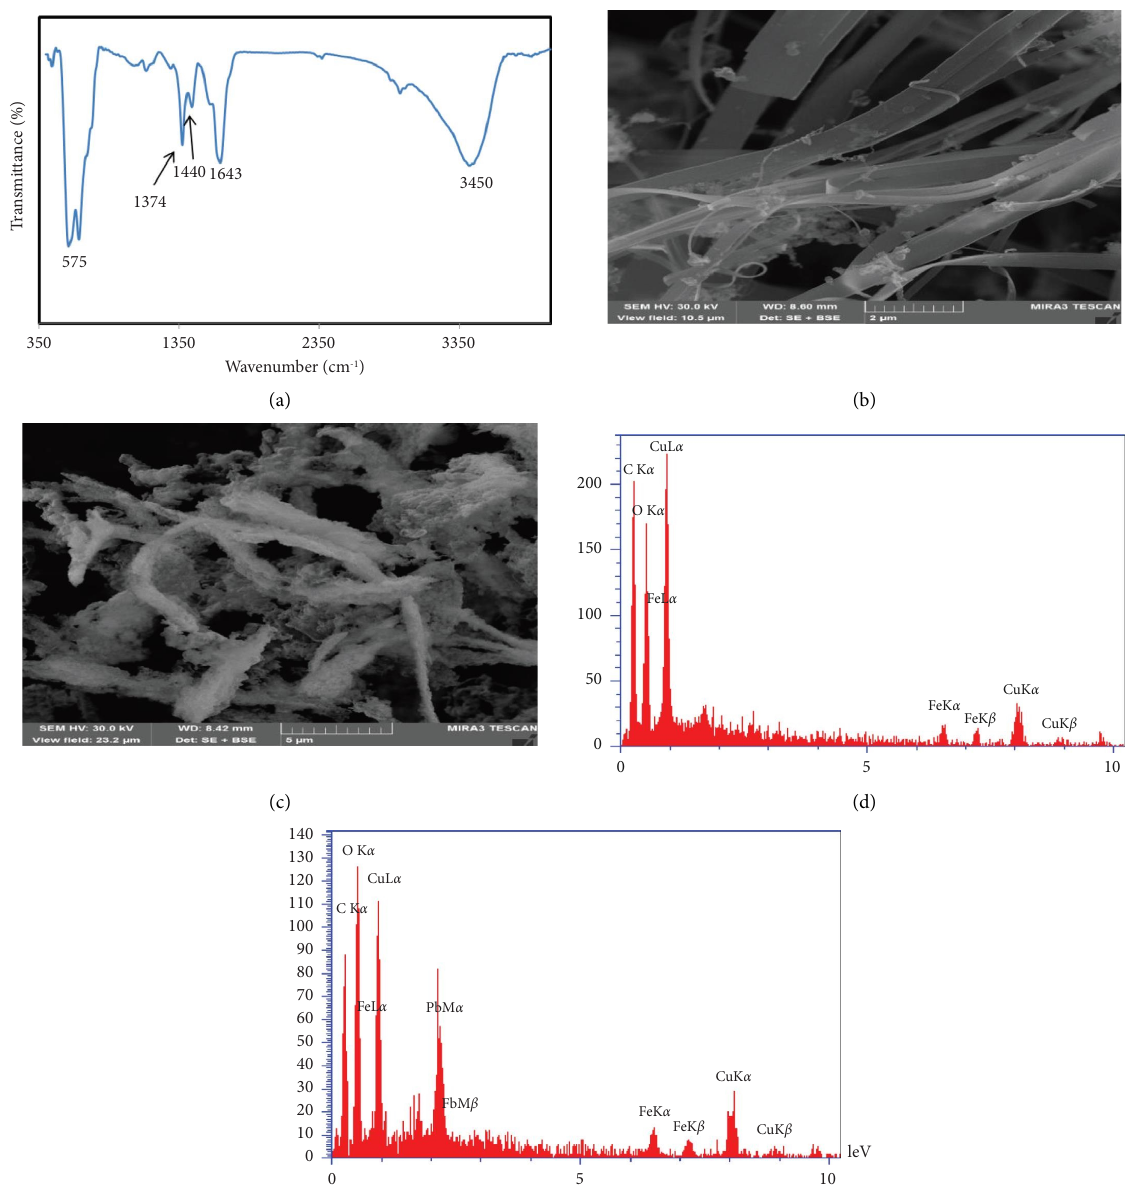
Figure 1: (a) FTIR spectra of Cu-BTC@Fe 3 O 4 nanocomposite. (b, c) SEM images of magnetic MOF before and after adsorption. (d, e) EDS images of Cu-BTC@Fe 3 O 4 nanocomposite before and after